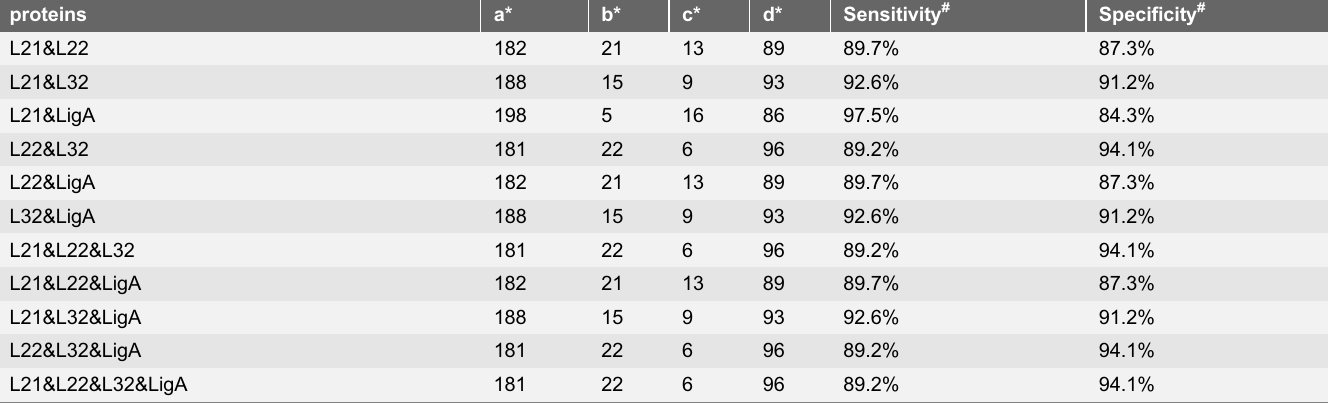
infection of the animals; Leptospira can only be cultured from blood samples in the acute phase which usually lasts for about 10 days. After the antibody response is detected (at approximately 10 days), Leptospira are cleared from the blood. During the second phase, which may last up to several months, bacteriuria is often intermittent, which makes the culture results inconsistent. For the same reason the molecular diagnossis of leptospirosis is only suitable in the early and convalescent stages of infection, although it has been shown to be sensitive and specific. Hence, currently most cases of leptospirosis are still diagnosed by serology. In infected animals, antibodies become detectable by the 6th to 10th day of disease and reach peak levels within three to four weeks. The antibody levels then gradually decline but still can be detected for years [34]. Thus, considerable efforts are being made to develop novel, sensitive, and specific serological diagnostic tests for leptospirosis that are less labor and resource intensive. Enzyme linked immunosorbent assay (ELISA) methods are a potential diagnostic tool for the serodiagnosis of leptospirosis [30, 35, 36]. Attempts have been made to develop either an ELISA serodiagnostic test [31, 37, 38, 39, 40, 41, 42, 43, 44] or a Dual Path Platform (DPP) assay, a point-of-care immunoassay [45]. We Table 3. Sensitivity and specificity of the ELISA test.